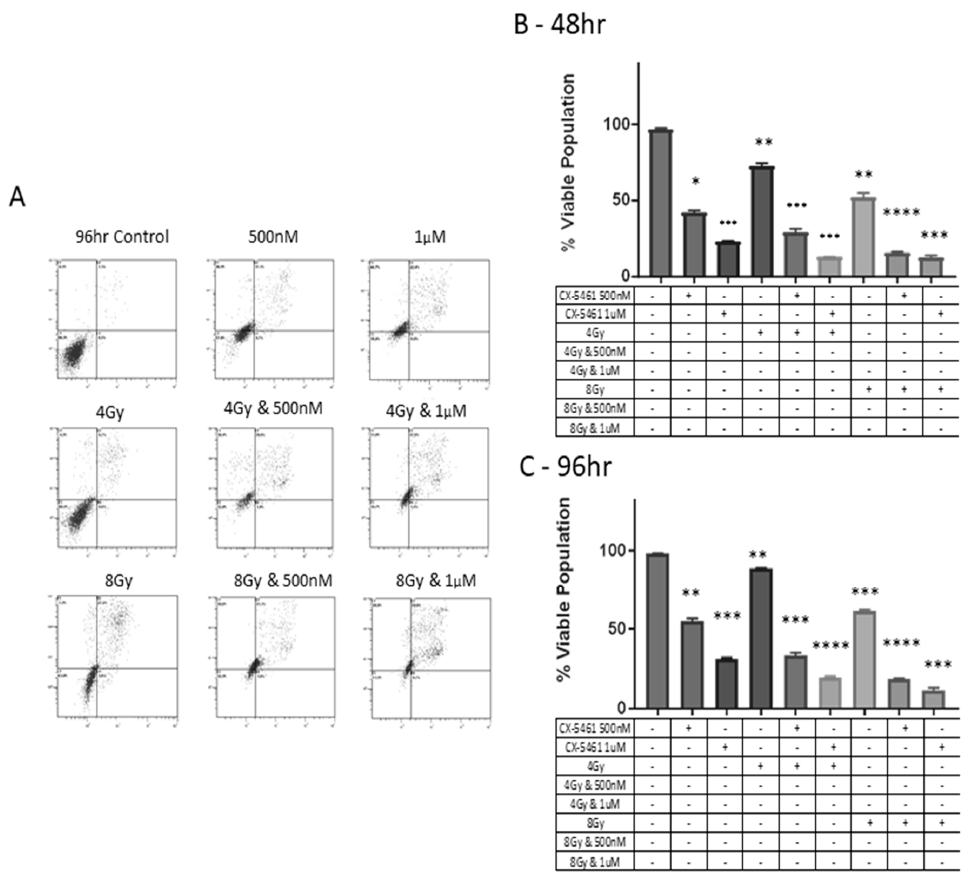
Figure 4. Flow cytometry analysis of combination treatments involving CX-5461 and single-dose X-